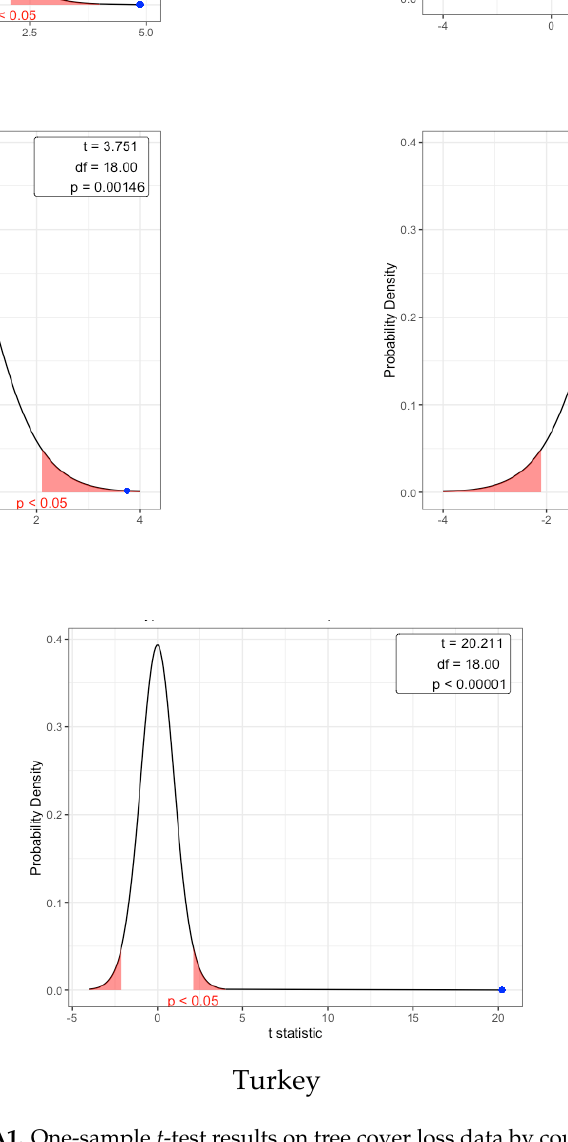
Figure A1. One-sample t-test results on tree cover loss data by country.